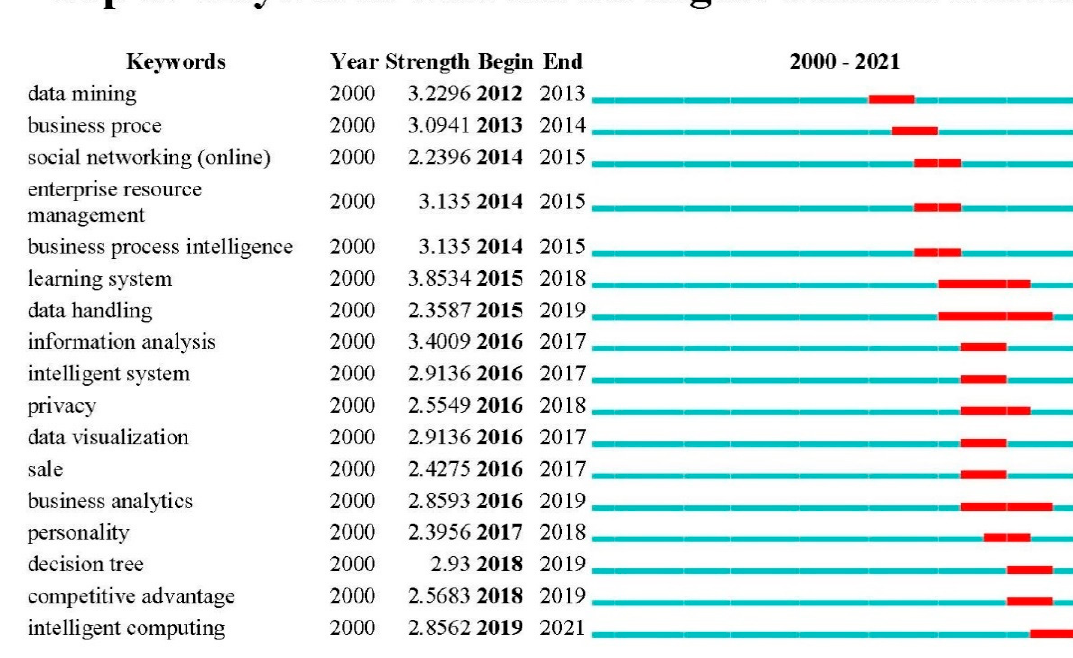
Figure 11. The top 17 citation burst history of keywords (The red part represents the burst period).